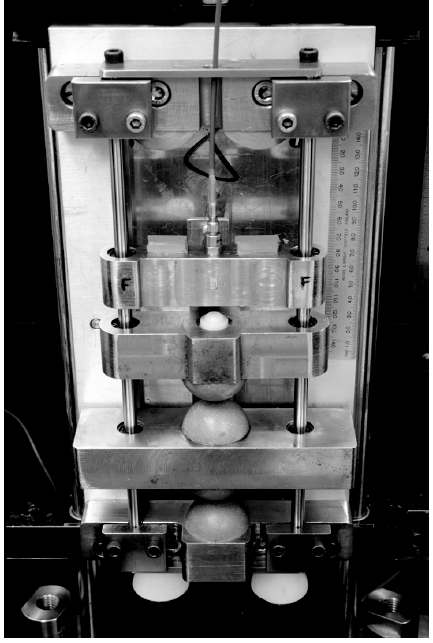
Fig. 19. Photograph of a four-mass vertically-stacked shock